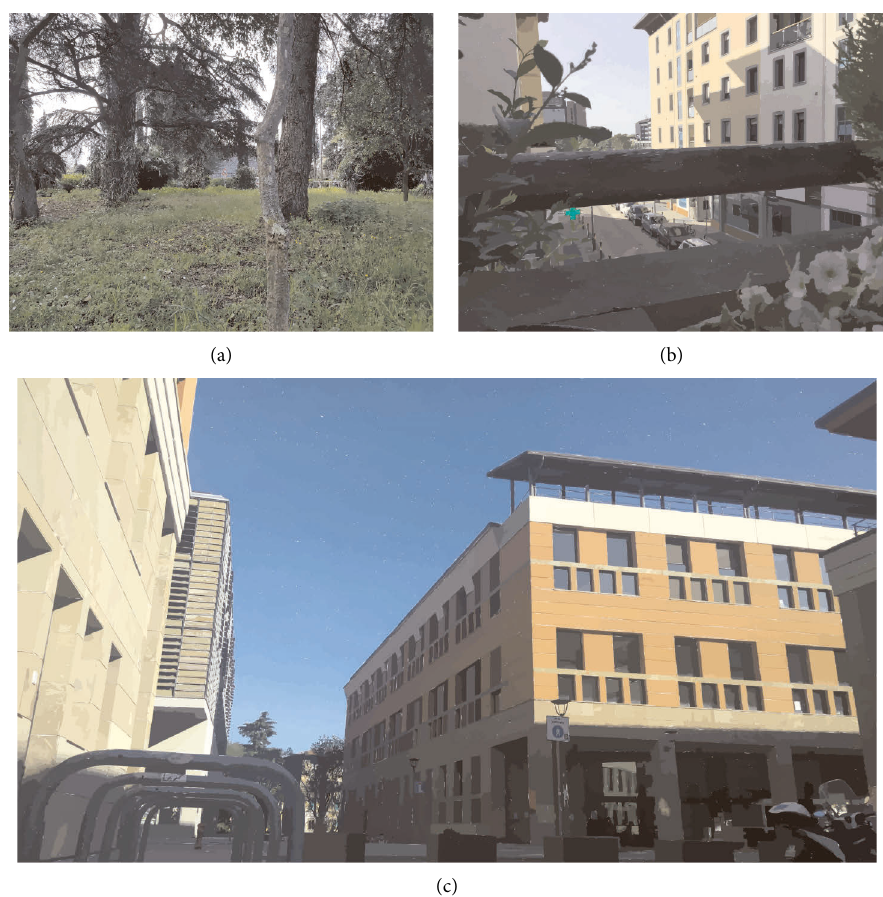
Figure 4: (a) Natural digital image captured by the digital camera in a smartphone Galaxy S7; (b) natural digital image captured by the digital camera in a smartphone iPad Air; (c) natural digital image captured by the digital camera in a smartphone Xiaomi Table 1: Eligible digital cameras used for the case studies considered in this work.